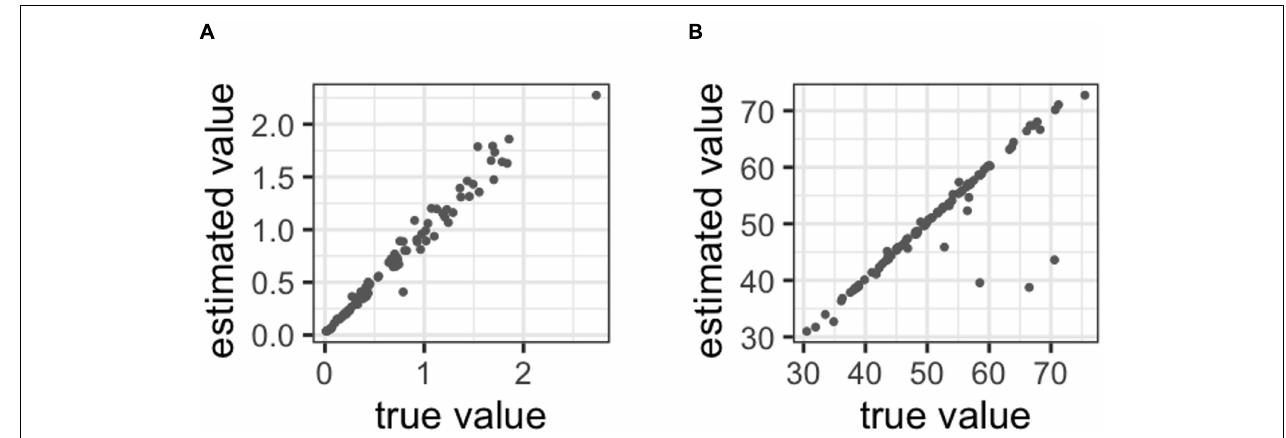
FIGURE 7 | (A) Correlations between the true values and estimated value in metacognitive ability, (B) correlations between the true values and estimated value in bias.